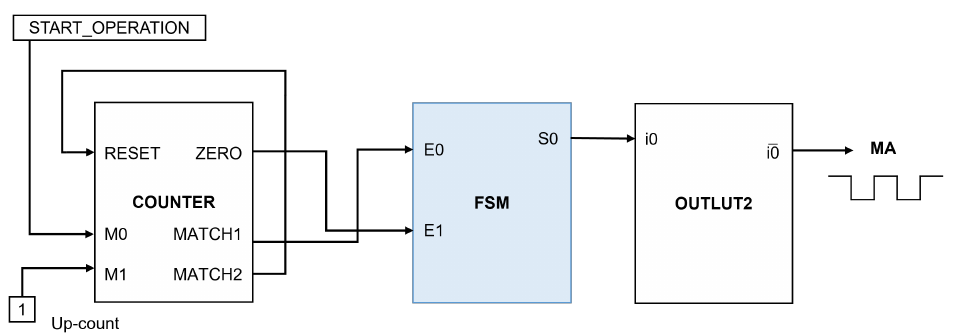
Figure 11. CLB structure for MA